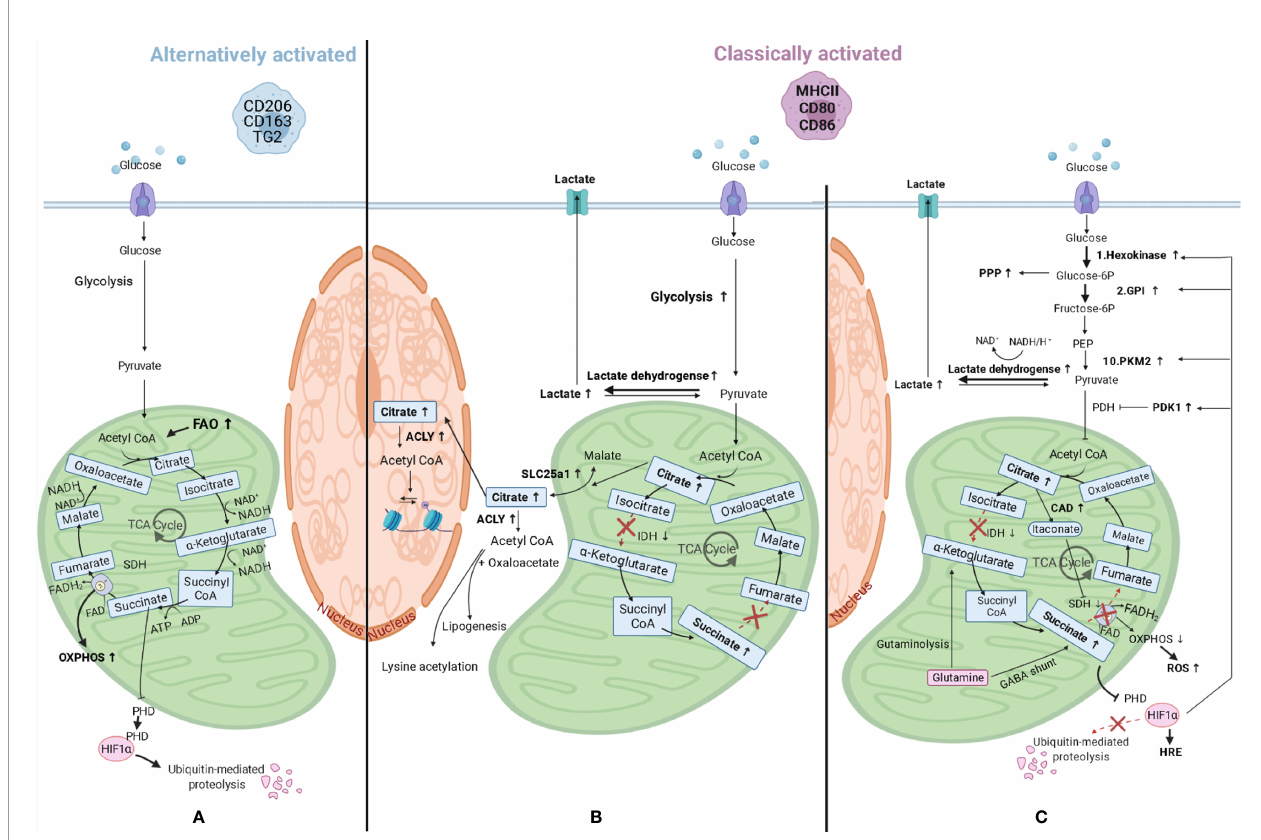
FIGURE 3 | Macrophage metabolic reprograming. (A) Alternatively activated macrophages have an induced fatty acid oxidation (FAO) and produce pyruvate from glycolysis and this is converted in acetyl-CoA, which is then used by the tricarboxylic acid (TCA) cycle to give electrons in the form of NADH and FADH 2 to the mitochondrial oxidative phosphorylation (OXPHOS) complexes to produce ATP. (B) When macrophages polarize to classically activated macrophages, metabolic reprogramming takes place and lactate is produced instead of pyruvate, and the TCA cycle is broken at two points, after citrate, and after succinate, resulting in the accumulation of these three metabolites. Citrate accumulates due to lower expression of isocitrate dehydrogenase (IDH) and can either be transported to the cytosol through solute carrier family 25 member 1 (SLC25a1), where it can be converted in acetyl-CoA by ATP citrate lyase (ACLY), or to the nucleus where the same conversion can take place. Acetyl-CoA can then be used for lysine acetylation or for lipogenesis. (C) Other changes in classically activated macrophages include succinate dehydrogenase (SDH) inhibition by itaconate, which is produced by upregulated cis-aconitate decarboxylase (CAD), and this results in succinate accumulation. Succinate levels can also increase as a consequence of augmented levels of glutamine anaplerosis, either through an upregulated GABA ( g - aminobutyric acid) shunt or through glutaminolysis. SDH is also part of the mitochondrial respiratory chain and its inhibition will lead to decreased mitochondrial respiration and increased ROS (reactive oxygen species) production. Succinate inhibits prolyl hydroxylase domain (PHD) proteins, resulting in less hydroxylation of hypoxia-inducible factor 1-alpha (HIF-1 a ), which circumvents its degradation and allows its binding to hypoxia response elements (HRE) on target genes (48). HIF-1 a also promotes the switch to glycolysis by inducing glycolytic enzymes like hexokinase 2 (1 st reaction of glycolysis), pyruvate kinase M2 (PKM2, 10 th reaction), and glucose-6-phosphate isomerase (GPI, 2 nd reaction). The enzyme product of the latter is used in the oxidative phase of the pentose phosphate pathway (PPP),